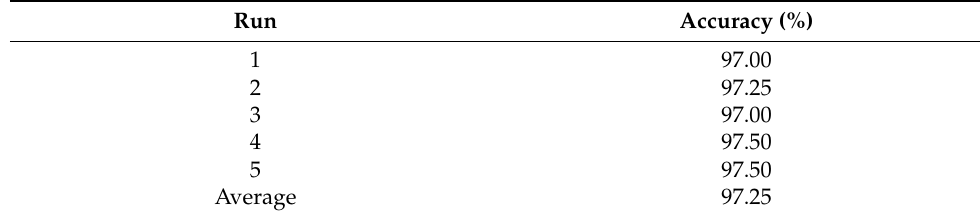
Table 1. The accuracy of model.